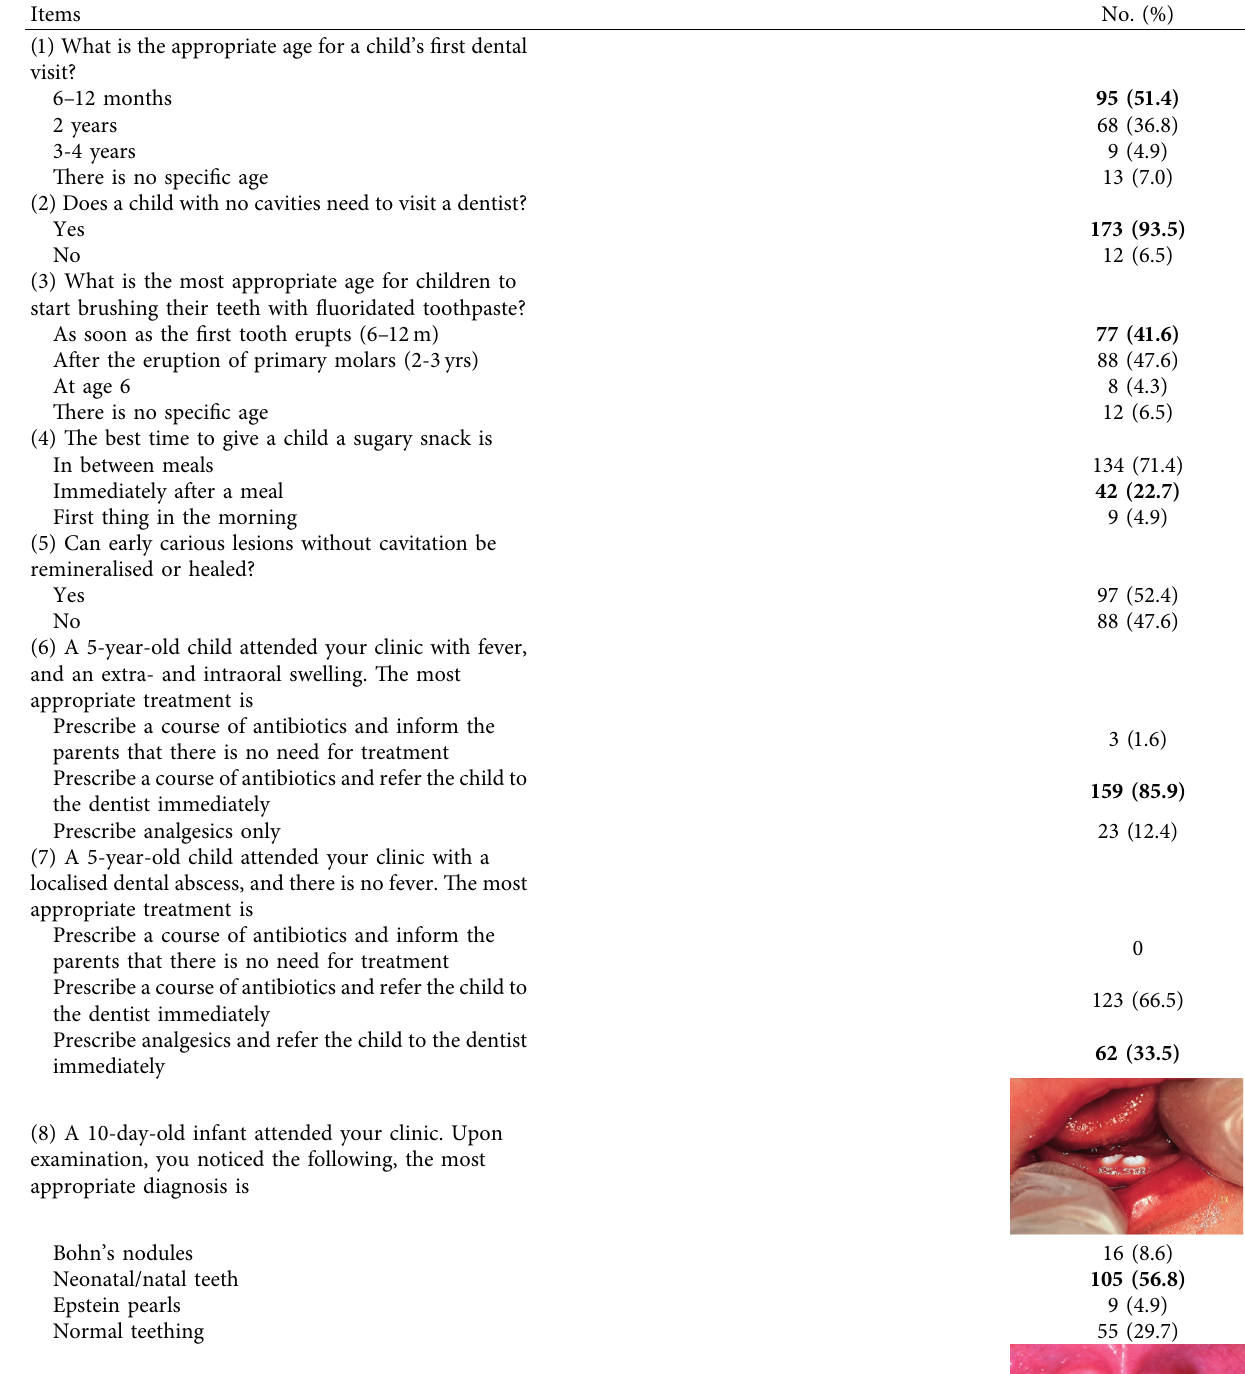
Table 2: Oral health knowledge